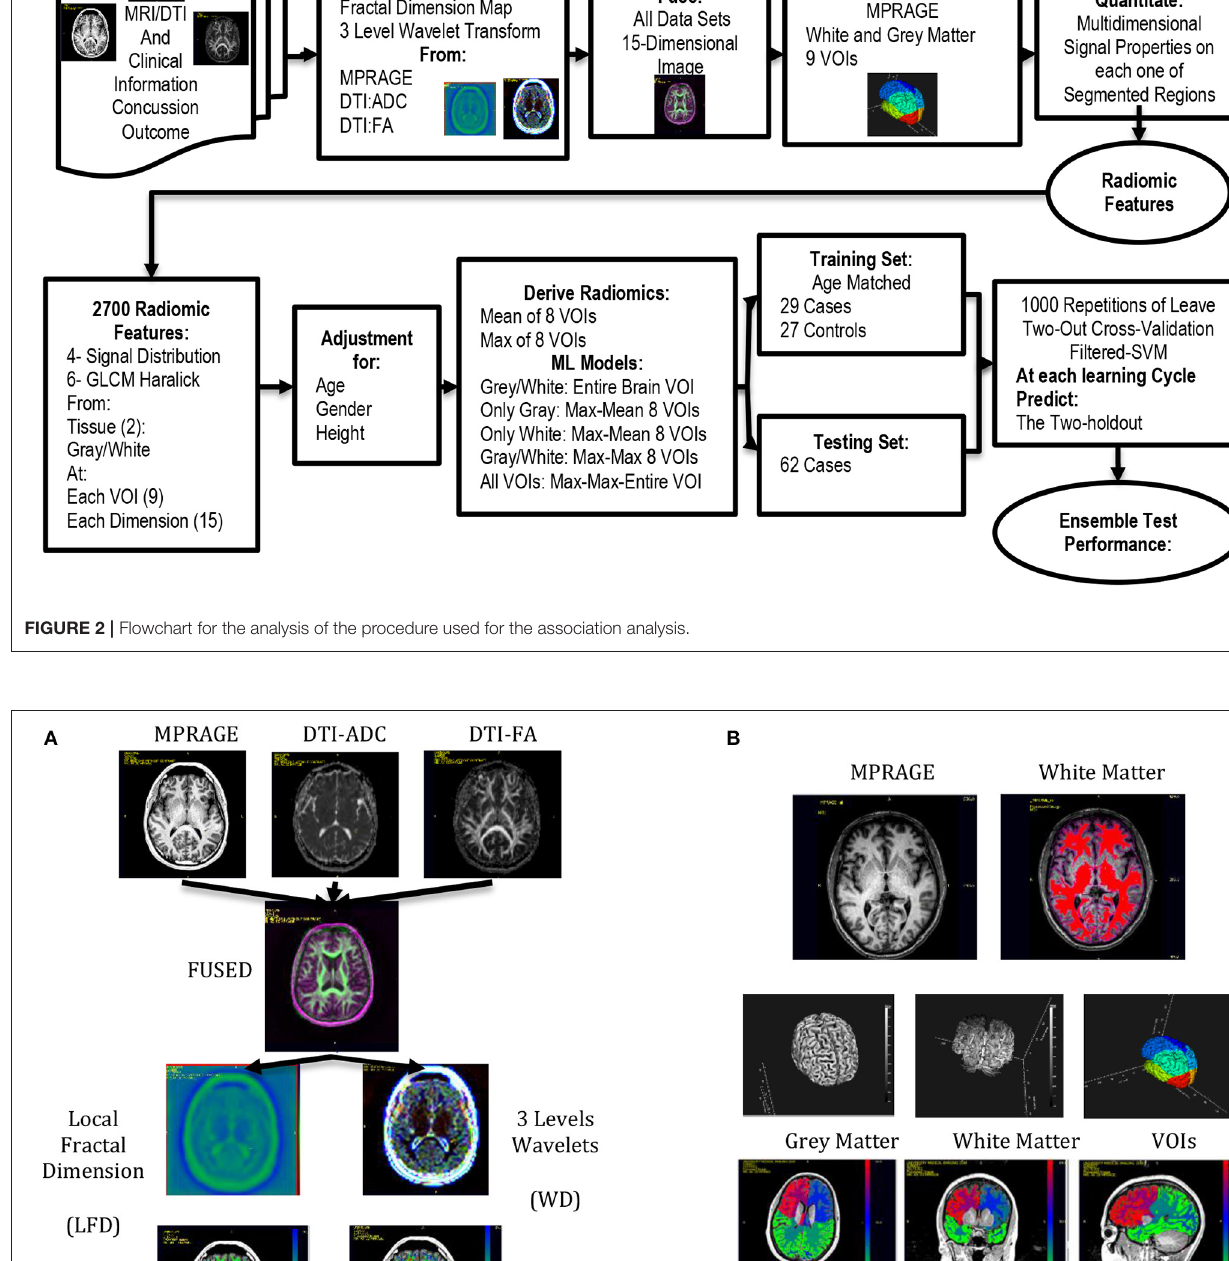
Frontiers in Neurology | www.frontiersin.org